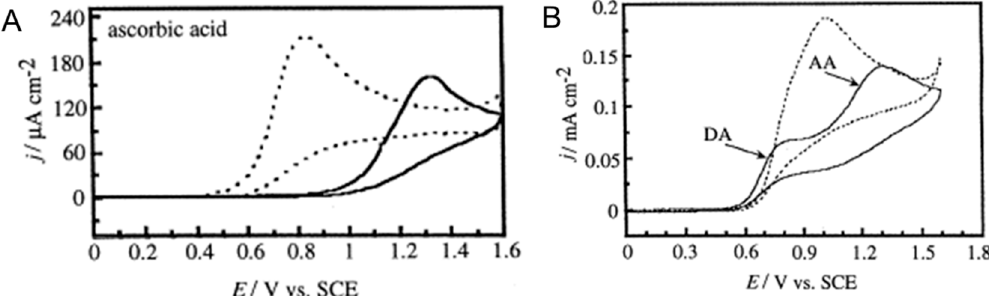
Figure 4. ( A ) Cyclic voltammograms for 1 mM AA at untreated (dashed lines) and anodically treated (solid lines) diamond electrodes in 0.1 M HClO 4 solution. Sweep rate, 100 mV s − 1 . ( B ) Cyclic voltammograms for a mixture of 0.1 mM DA and 1 mM AA at untreated (dashed line) and anodically treated (solid line) diamond electrodes in 0.1 M HClO 4 solution. Sweep rate, 100 mV s − 1 . (Reproduced from [187] with